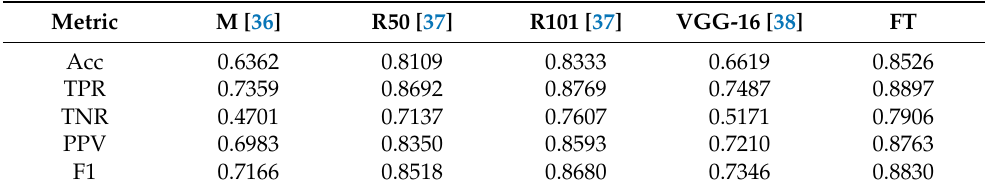
Table 4. Performance comparison on the Zhang chest X-ray dataset. The proposed framework with ResNet101 [37] achieved comparable performance to the fine-tuned